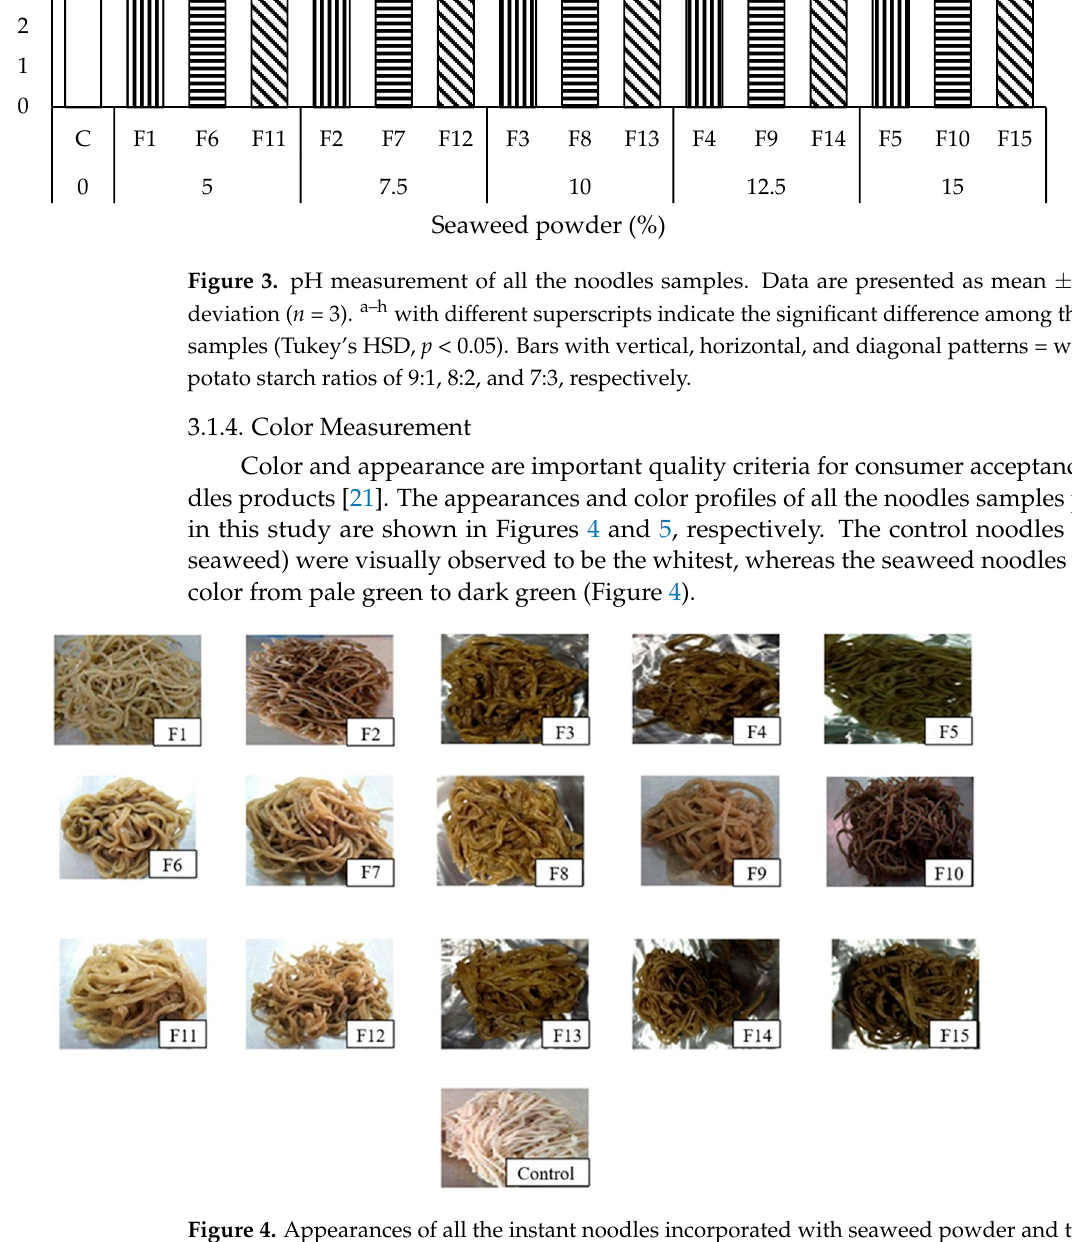
Figure 4. Appearances of all the instant noodles incorporated with seaweed powder and the control noodles (without seaweed powder).